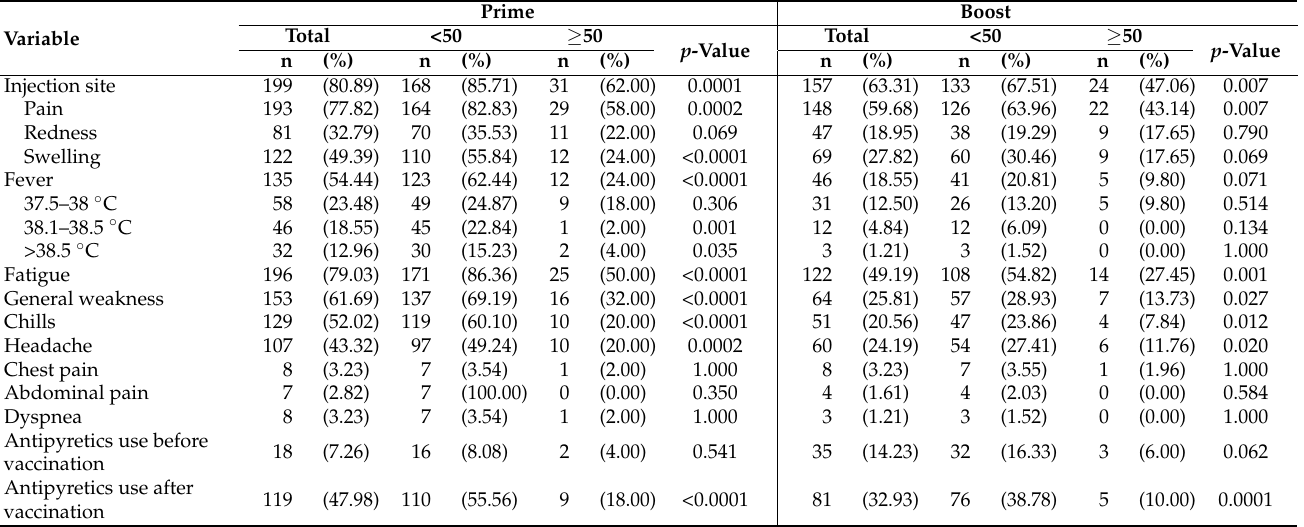
Table 3. Solicited reactogenicity of the prime–boost vaccinations and antipyretics use between participants aged <50 years and ≥ 50 years.